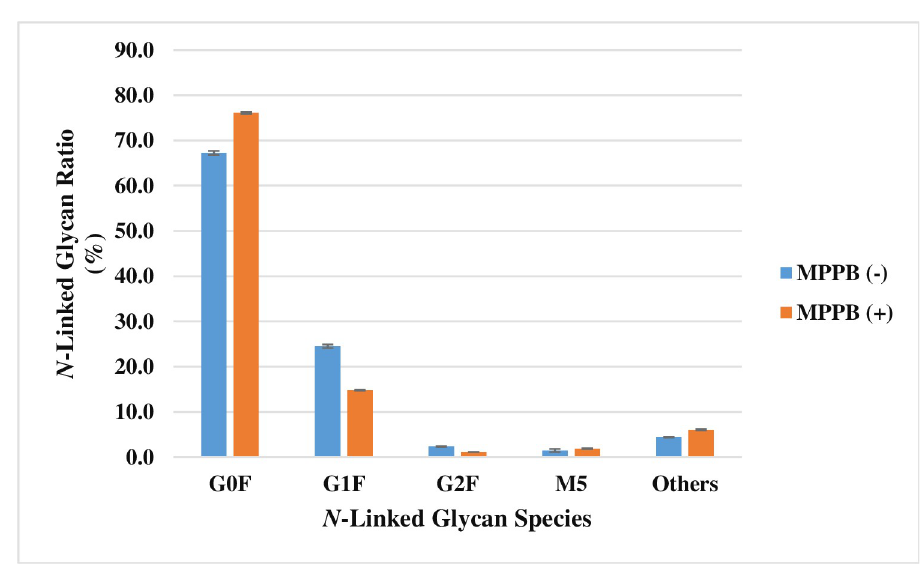
Fig 11. MPPB suppresses galactosylation of mAb. Each value was calculated as the percentage of total N -linked glycans. The ratio was statically analyzed.